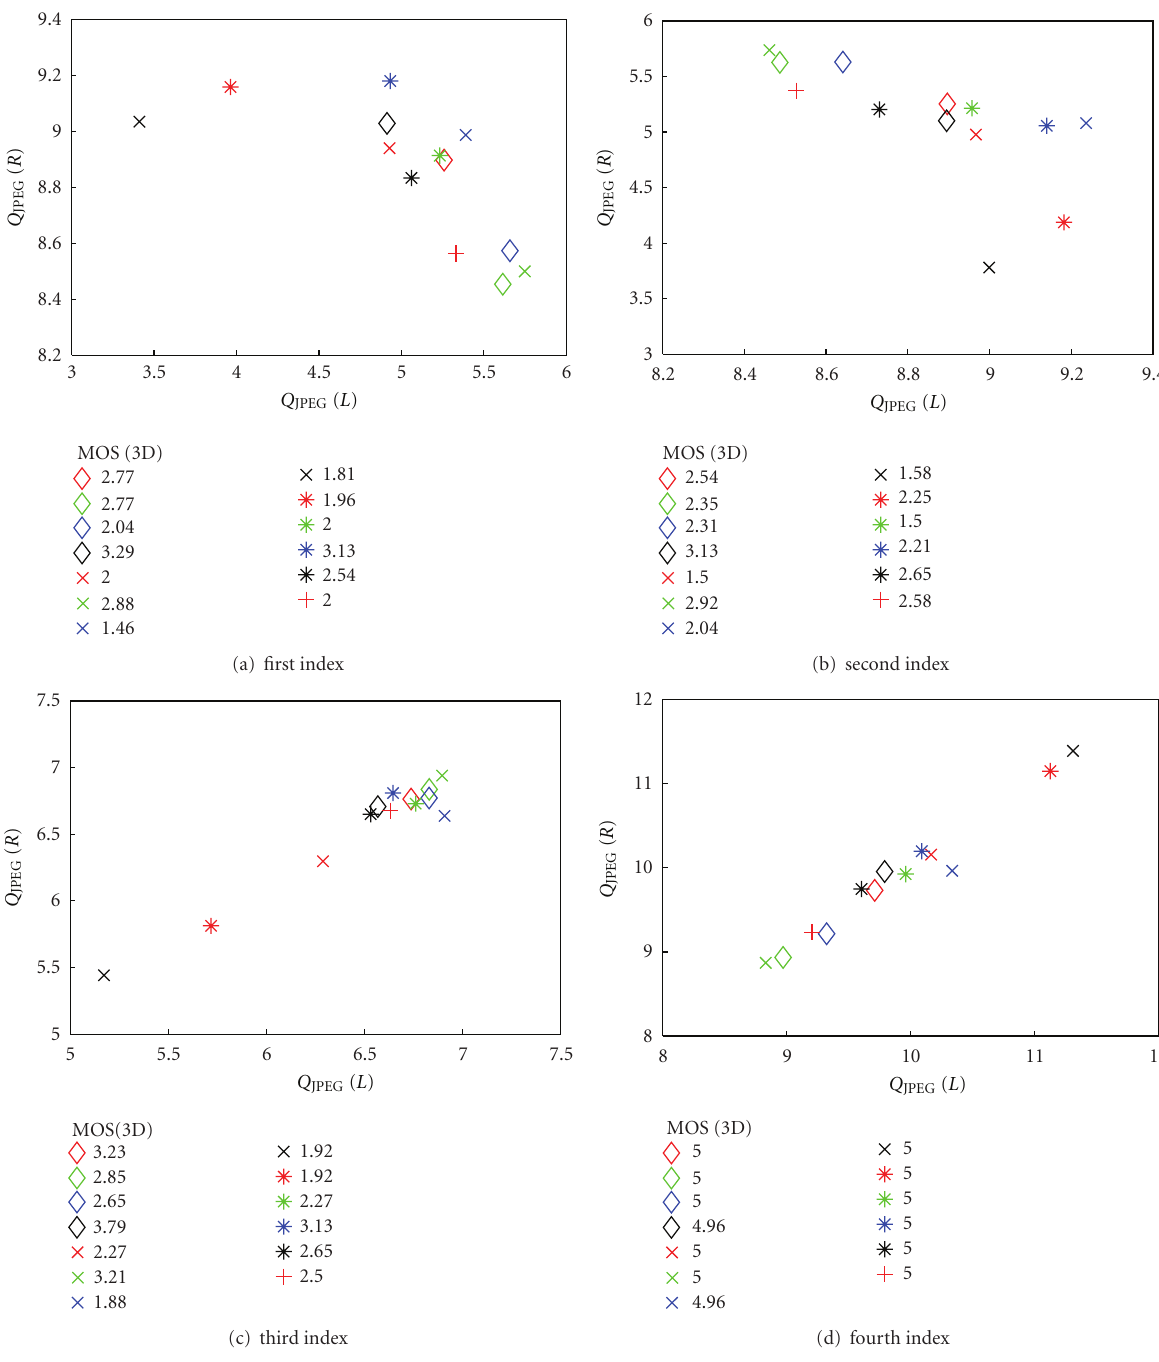
right image qualities, and, moreover, the “distress” feeling becomes more serious with their larger